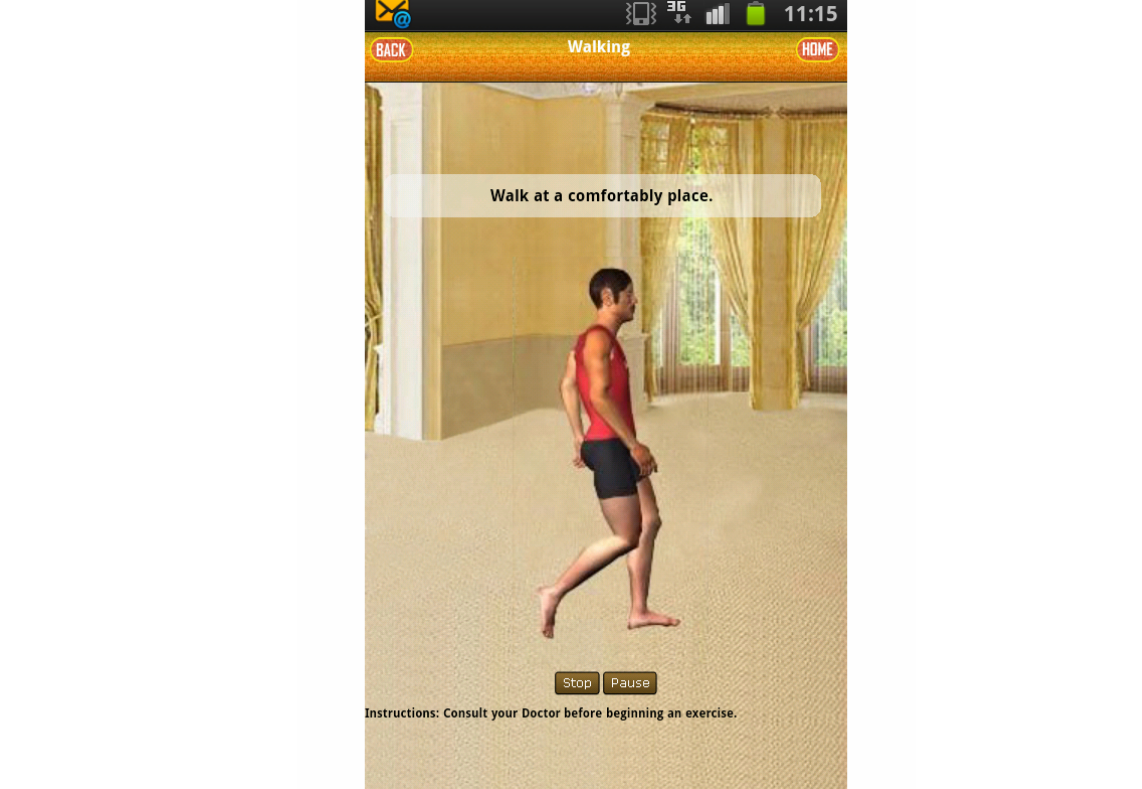
Figure 9. Snapshot of Positive